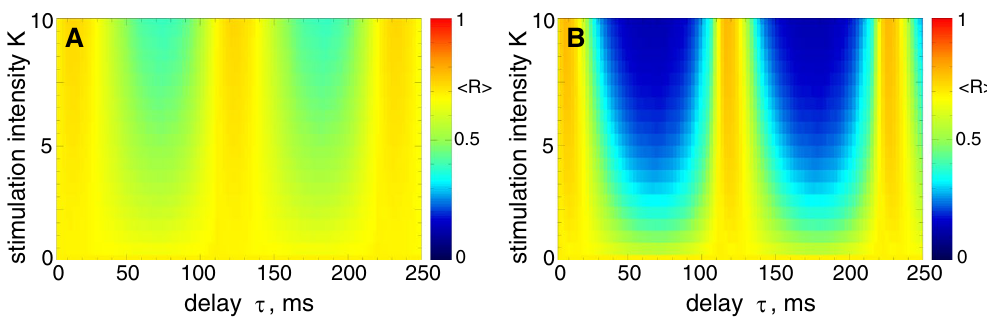
Figure 6. Impact of the pulsatile LDF stimulation (6) on the neuronal ensemble (1)–(3). The time-averaged order parameter 〈 R ( t ) 〉 of the stimulated STN neurons is depicted in color ranging from 0 (blue) to 1 (red) versus feedback delay τ and stimulation intensity K for the interphase gap width ( A ) GW = 0 ms and ( B ) GW = 5